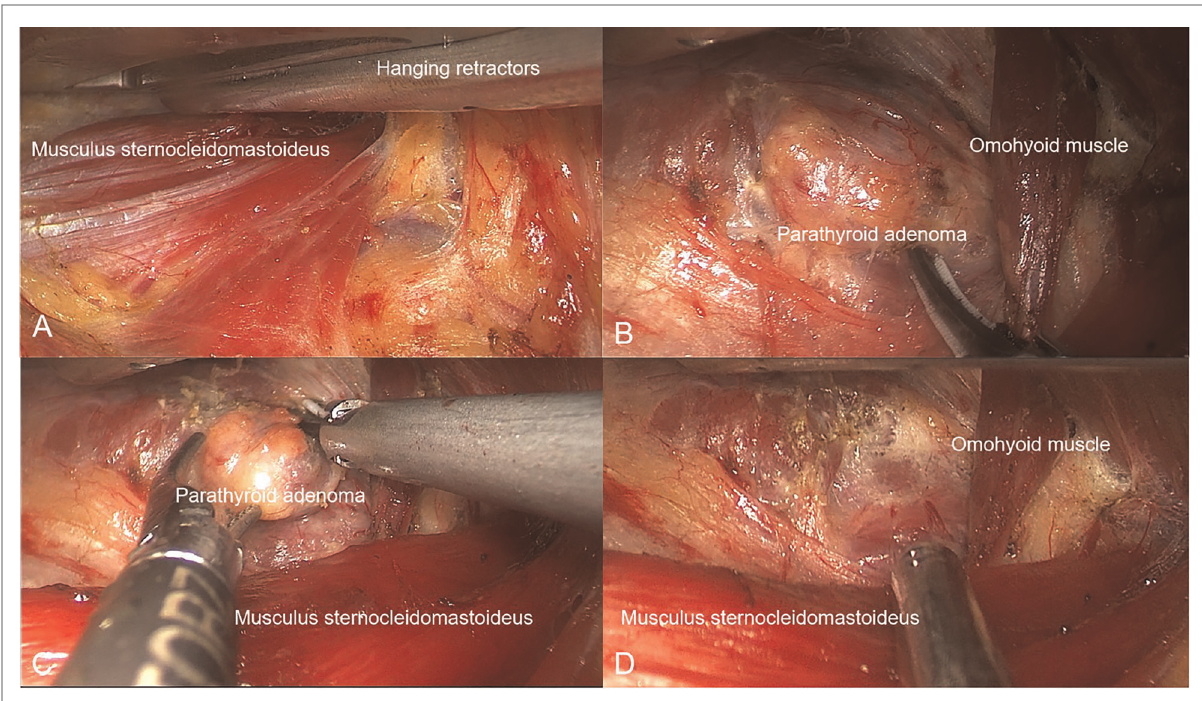
FIGURE 1 Unilateral gasless axillary access parathyroid surgery step ( A ) separate the sternal head of the sternocleidomastoid muscle from the clavicular head. ( B ) Exploration was performed to expose the parathyroid tumor in the left upper pole. ( C ) Complete excision of this parathyroid tumor. ( D ) Full display of resected surgical cavity.